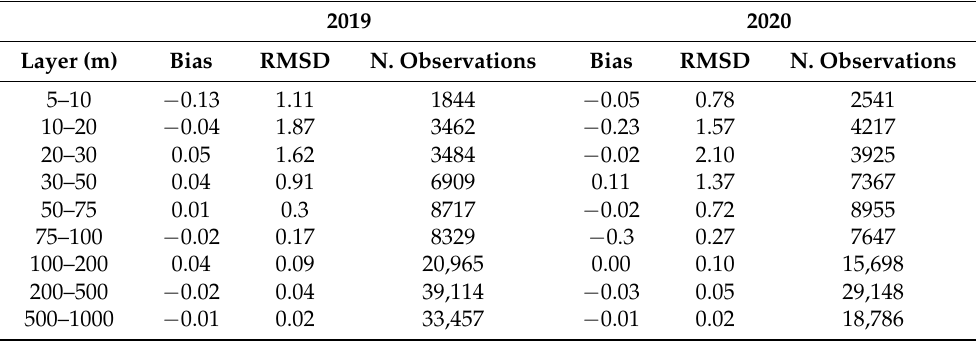
Table 2. EANs for temperature ( ◦ C) in terms of bias and RMSD for 2019–2020, including number of observations used in the